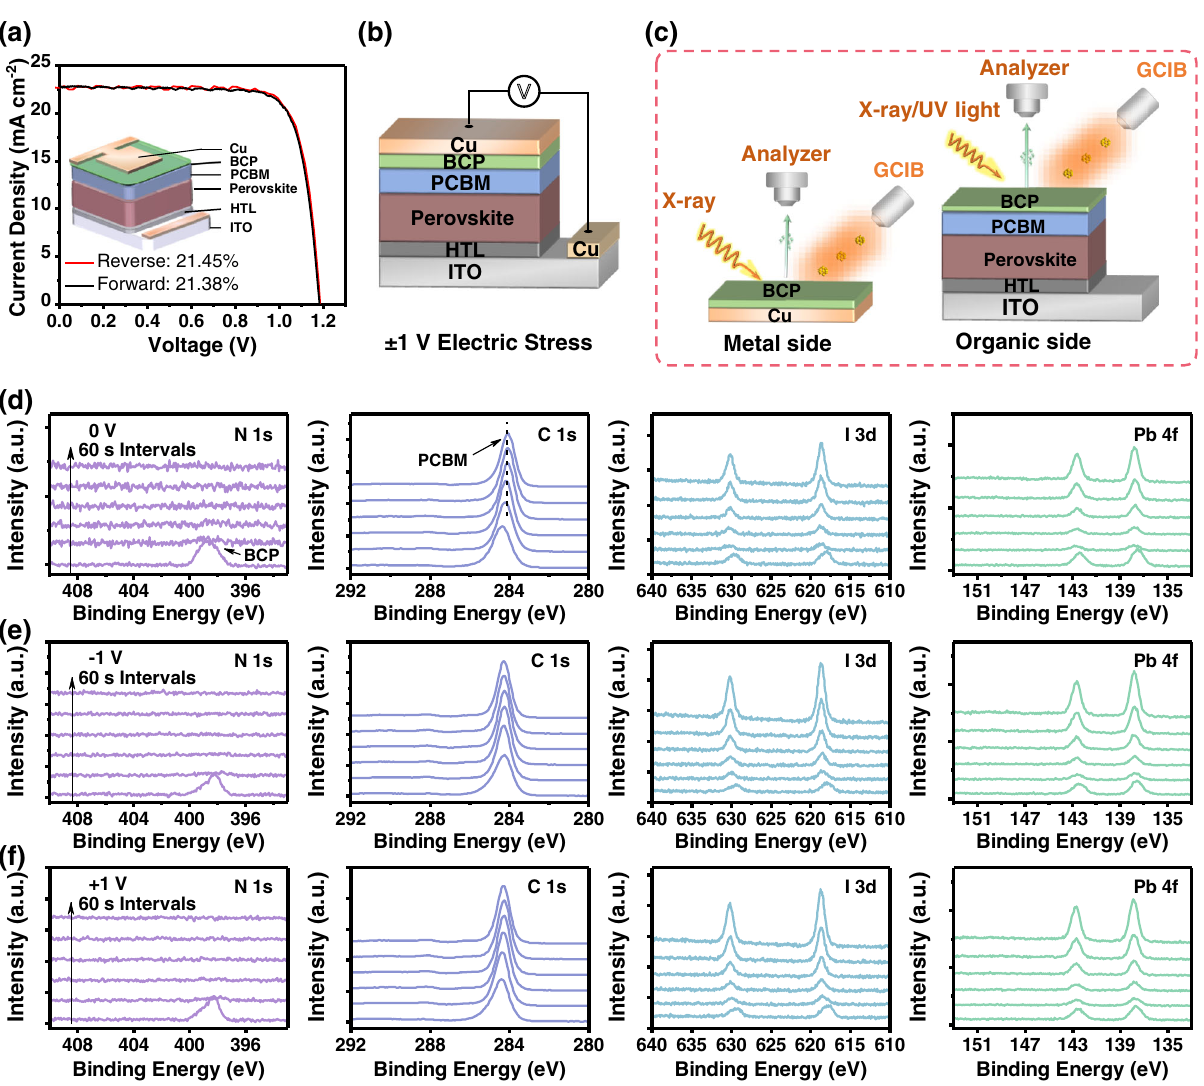
Fig. 1 Device performance and XPS depth pro fi les. a Typical J – V curves for the inverted planar heterojunction PSCs from both the forward and reverse scans. (Inset) A PSC consists of glass/ITO (indium tin oxide)/HTL (8 nm)/perovskite (500 nm)/PCBM (30 nm)/BCP (8 nm)/Cu (100 nm). HTL, hole transporting layer. PCBM (phenyl-C61-butyric acid methyl ester, C 72 H 14 O 2 ) and BCP (bathocuproine, C 26 H 20 N 2 ) are the electron transporting and hole blocking layers, respectively. b Schematic illustration of the PSCs with the electric stress of ±1 V. The whole process was conducted in a dark N 2 - fi lled glove box without exposure to air. c Illustration of two surfaces cleaved from the same device for depth-dependent XPS and UPS analyses. d – f Depth XPS pro fi les for the BCP side cleaved from the full PSCs with and without electric stress: d 0 V, e − 1 V and f + 1 V. The XPS depth pro fi les for the BCP side with and without electric stress are provided in Supplementary Table 2. Note that the metallic Pb (Pb 0 ) was observed from the XPS spectra once sputtering the perovskite absorber (Supplementary Fig.